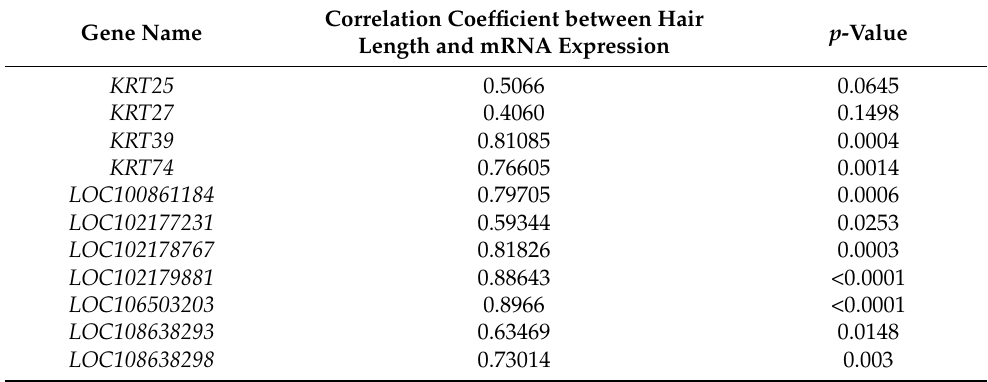
Table 5. Correlation analysis between the expression of genes’ mRNA and hair length traits. Gene